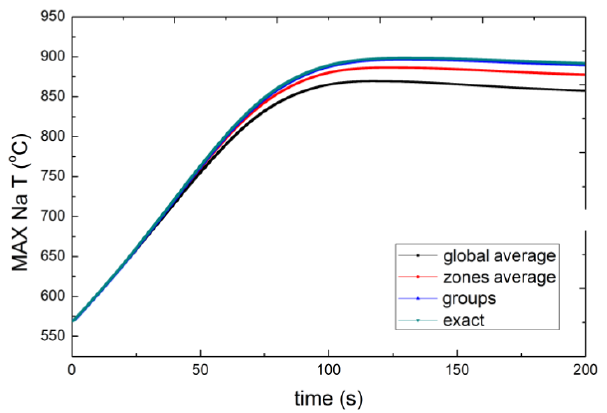
Fig. 10. Average fi ssile temperature during ULOF/PP for different H